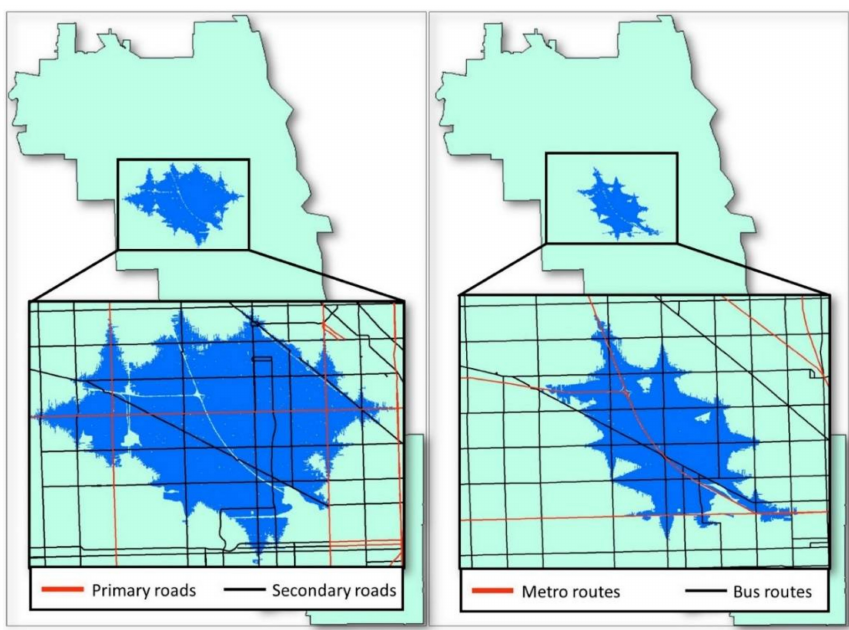
Figure 8. Crystal-growth activity space based on accessibility-weighted plane for private transport users ( left ) and public transport users ( right